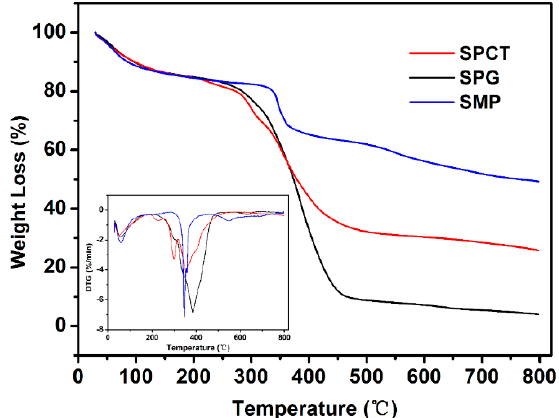
Figure 3. Thermogravimetic analysis (TGA) curve of SMP, SPG and SPCT.